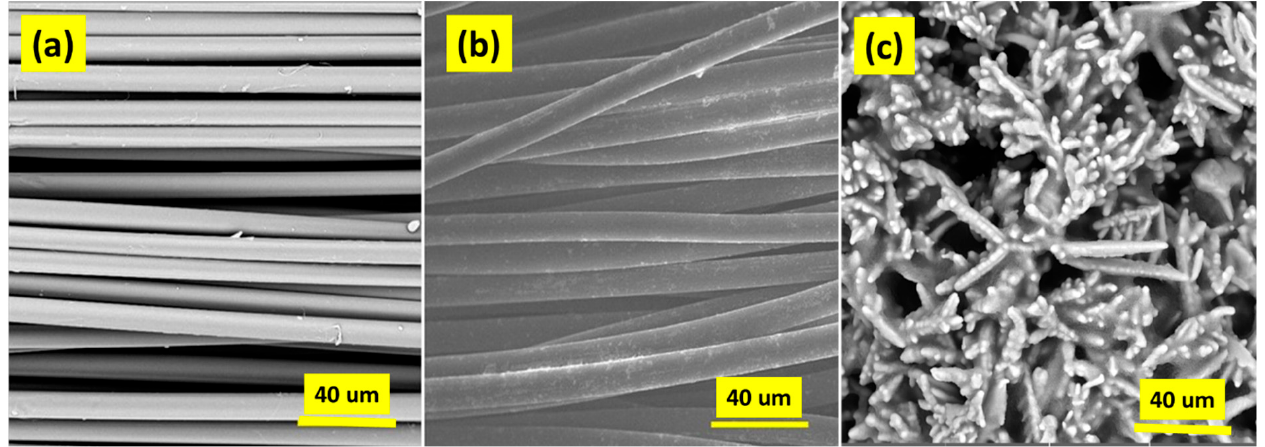
Figure 8. SEM images of ( a ) untreated fiber, ( b ) chemically treated fiber, and ( c ) fiber-reinforced composite.